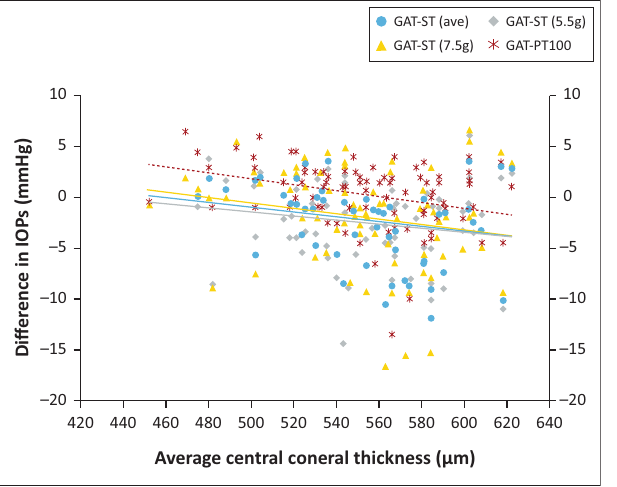
FIGURE 5: Relationship between Goldmann applanation tonometer and PT-100 non-contact tonometer-measured intraocular pressure differences and central corneal thickness. The scatterplot shows a negative correlation between intraocular pressure measurements (Goldmann applanation tonometer-other devices) and central corneal thickness, which reached a level of significance ( p < 0.05).